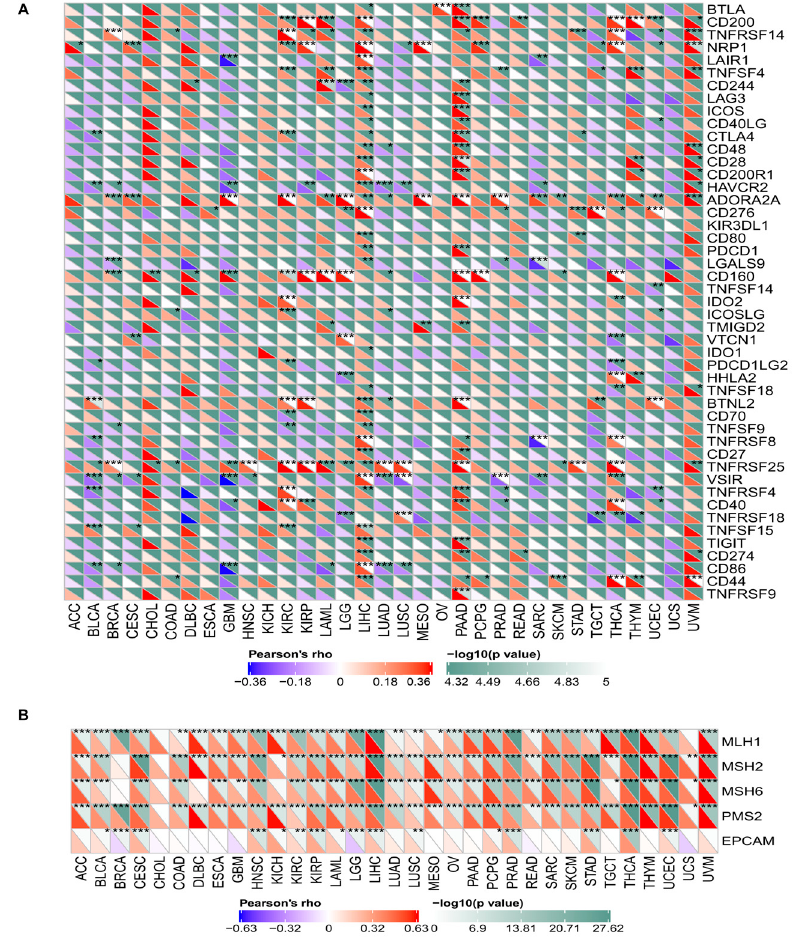
Figure 3. ( A ) Correlation analysis between expression levels of METTL3 and expression levels of immune checkpoint genes in pan-cancer (* p < 0.05, ** p < 0.01, *** p < 0.001). ( B ) Correlation analysis between METTL3 expression and mismatch repair (MMR) gene expression (* p < 0.05, ** p < 0.01, *** p < 0.001).